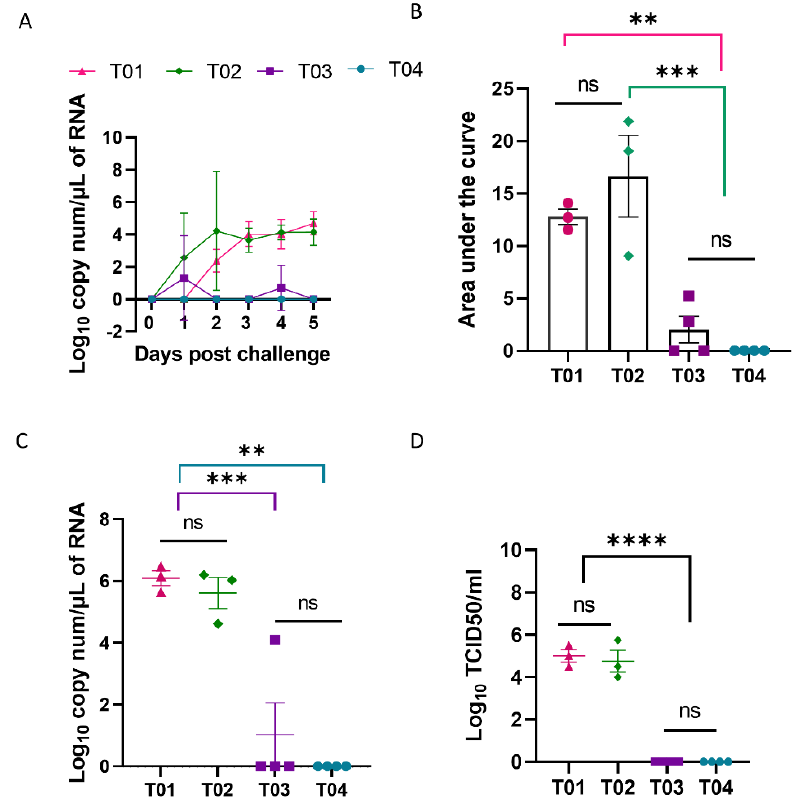
Figure 4. IAV-S shedding post challenge. ( A ) IAV-S NP RNA in nasal swab samples as quantified by RT-PCR. Data are expressed as log 10 RNA copy per µ L of RNA sample loaded to the PCR reaction. ( B ) Area under each curve of the nasal viral loads in pigs in the course of 5 days post challenge infection with IAV-S. ( C ) IAV-S NP RNA in BALF collected during necropsy at day 5 post challenge. ( D ) Infectious IAV-S in BALF samples measured by virus titration in MDCK cells. T01—PBS; T02—rPICV-GFP; T03—rPICV-H3; T04—H3-protein. ns—no significance, ** p ≤ 0.01, *** p ≤ 0.001, **** p ≤